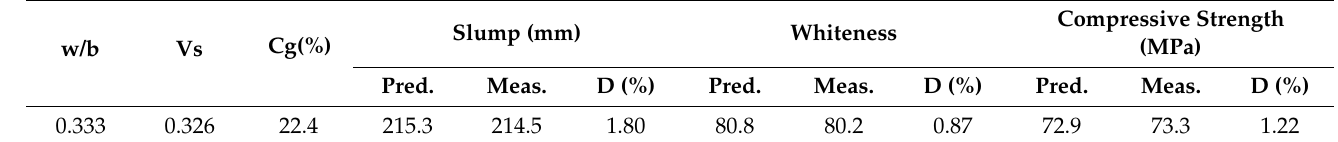
Table 11. Comparison of predicted values (pred.) and measured values (meas.) after parameter op ‐ timization.